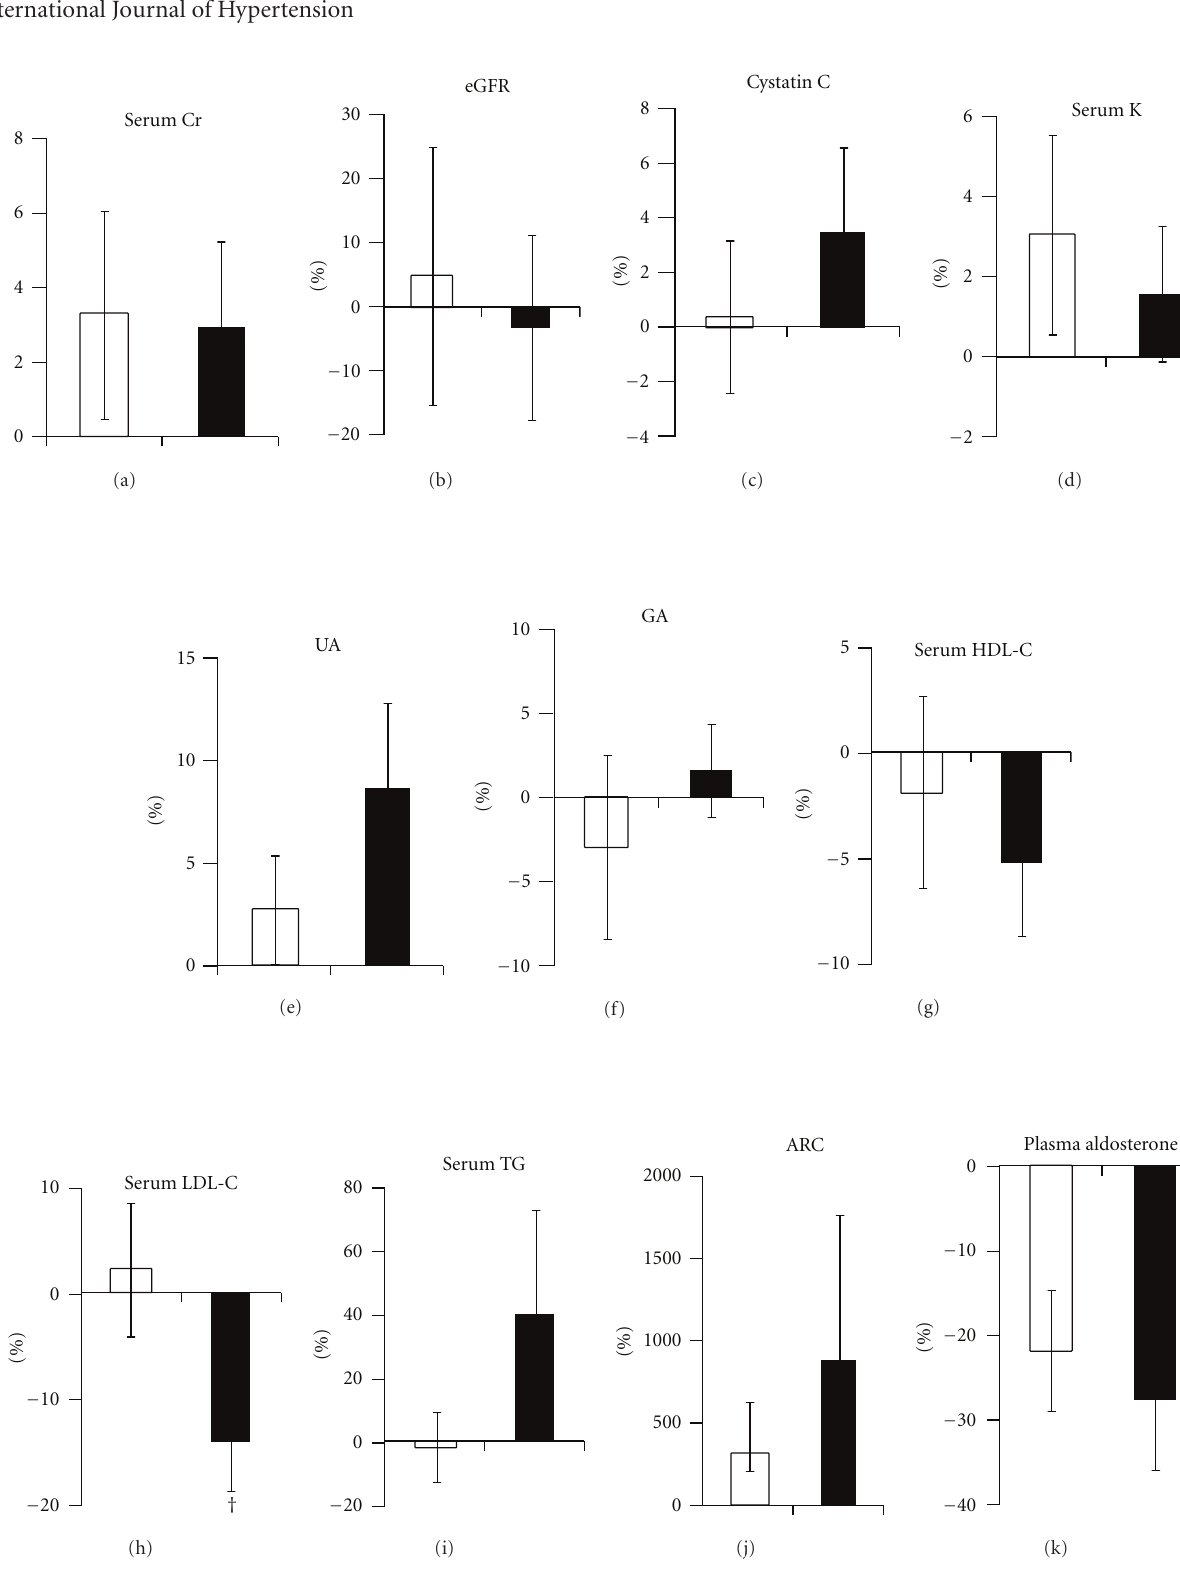
Figure 4: Changes from the baseline value for serum creatinine (Cr), estimated glomerular filtration rate (eGFR), serum cystatin C, serum K, serum uric acid (UA), glycoalbumin (GA), serum high density lipoprotein cholesterol (HDL), serum low density lipoprotein cholesterol (LDL-C), serum triglyceride (TG), plasma active renin concentration (ARC), and plasma aldosterone during 12 months of treatment with olmesartan monotherapy (open circles) or combination therapy with olmesartan and azelnidipine (closed circles). † P < . 05 versus the olmesartan